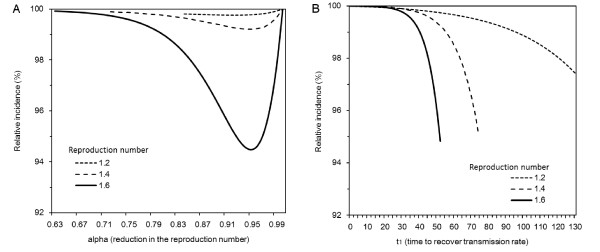
Sensitivity analysis of peak prevalence to the efficacy and length of intervention. A. Sensitivity of relative peak prevalence of infectious individuals to reduction in the reproduction number, α. The vertical axis represents I(tm,1)/I(tm,0), where I(tm,0) and I(tm,1) represent the peak prevalence in the absence and presence of intervention, respectively. The time length of intervention, t1 is fixed at Day 50. B. Sensitivity of relative peak prevalence of infectious individuals to the time length of the intervention, t1. α is fixed at 0.90. For both panels, the lines are truncated to satisfy αR(0) ≥ 1 and t1 <tm,0 where tm,0 is the time to observe peak prevalence in the absence of intervention.